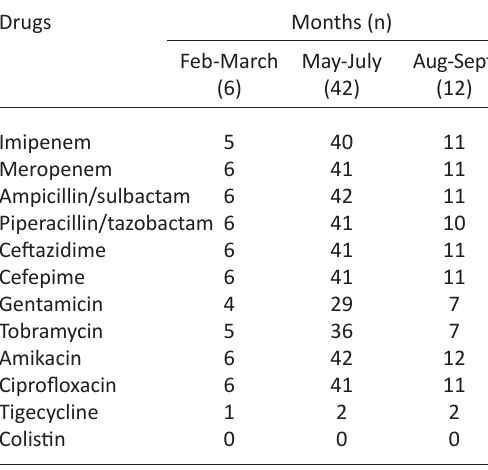
Table 4. The resistance rates of nosocomial A. baumannii